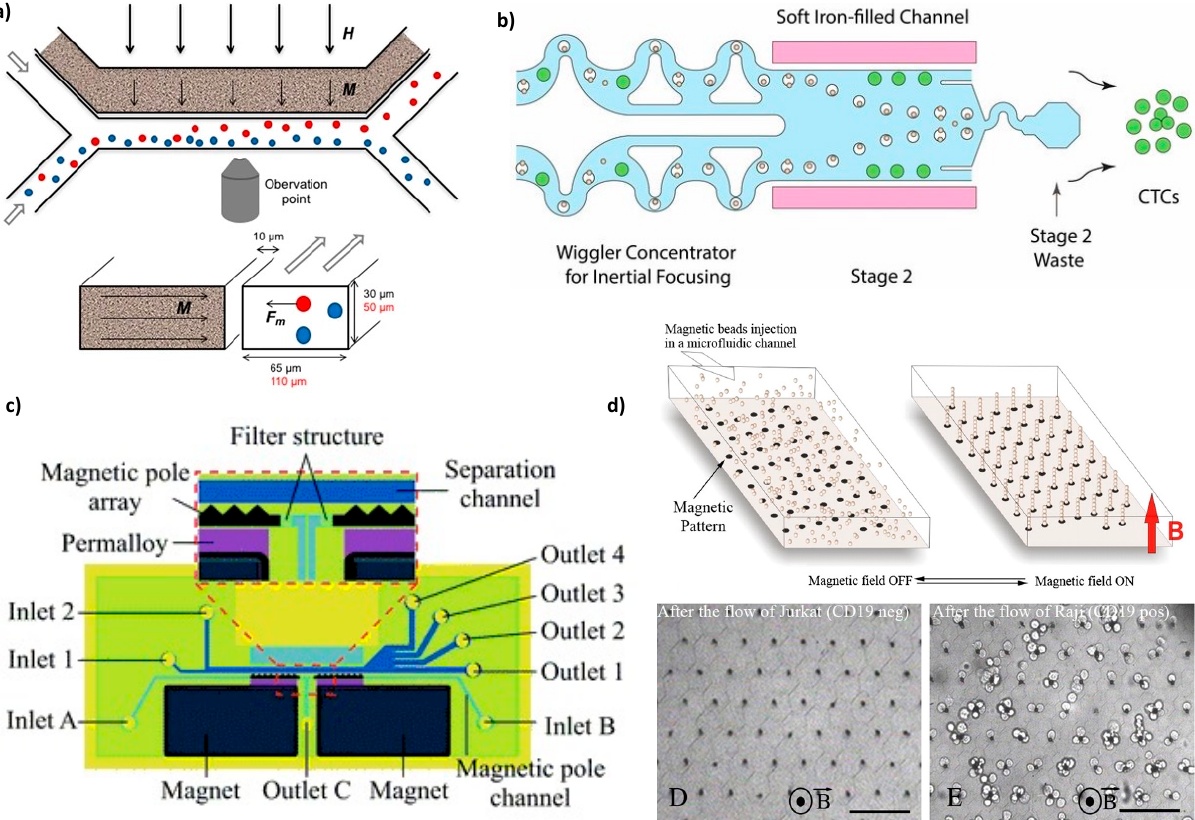
Figure 4. Microdevices with magnetically charged liquids used to trap or sort cells . ( a ) Design of the device seen from above (top) and as a cross-section through the channels (bottom). In the presence of an external magnetic field (thick arrows, H), the ferrofluid in the channel at 10 µm from the sorting channel magnetizes (thin arrows, M) and produces an attractive force (Fm) acting on magnetic cells (red), whereas non-magnetic cells (blue) continue in the sample flow. Reprinted from [73] with permission (http://creativecommons.org/licenses/by/4.0/). ( b ) Illustration of a magnetic sorter able to deplete ≈ 3 billion WBCs (white blood cells) per hour from concentrated leukapheresis products. A first size-based inertial separation removes RBCs (red blood cells) and platelets. In stage 2, two channels, one on each side of the sorting channel are compactly packed with soft magnetic iron particles. Immunomagnetically labeled WBCs (white dots with beads) are deflected in the waste well 2, whereas CTCs (circulating tumor cells, green dots) are collected at the chip output. Reprinted from [76] with permission (http://creativecommons.org/licenses/by/4.0/). ( c ) Chip detail and an enlarged view of the separation region: the microfluidic structures are made of PDMS by soft lithography and bonded to a glass substrate, the magnetic pole arrays are filled with Fe 3 O 4 powder, and the magnets are placed in opposite directions. Reprinted from [77], with the permission of the Royal Society of Chemistry (RSC). ( d ) Design of the Ephesia system (top): beads coated with an antibody are injected in a microchannel patterned with an array of magnetic ink, and the application of an external vertical magnetic field (red arrow) induces the formation of regular bead columns on top of the ink dots. Optical micrographs showing the application of the device (bottom): columns after the passage of 1000 Jurkat cells that exited the array (left) and columns after the passage of 400 Raji cells that were captured (right). Reprinted from [78] with permission of PNAS. Scale bars: 80 µ